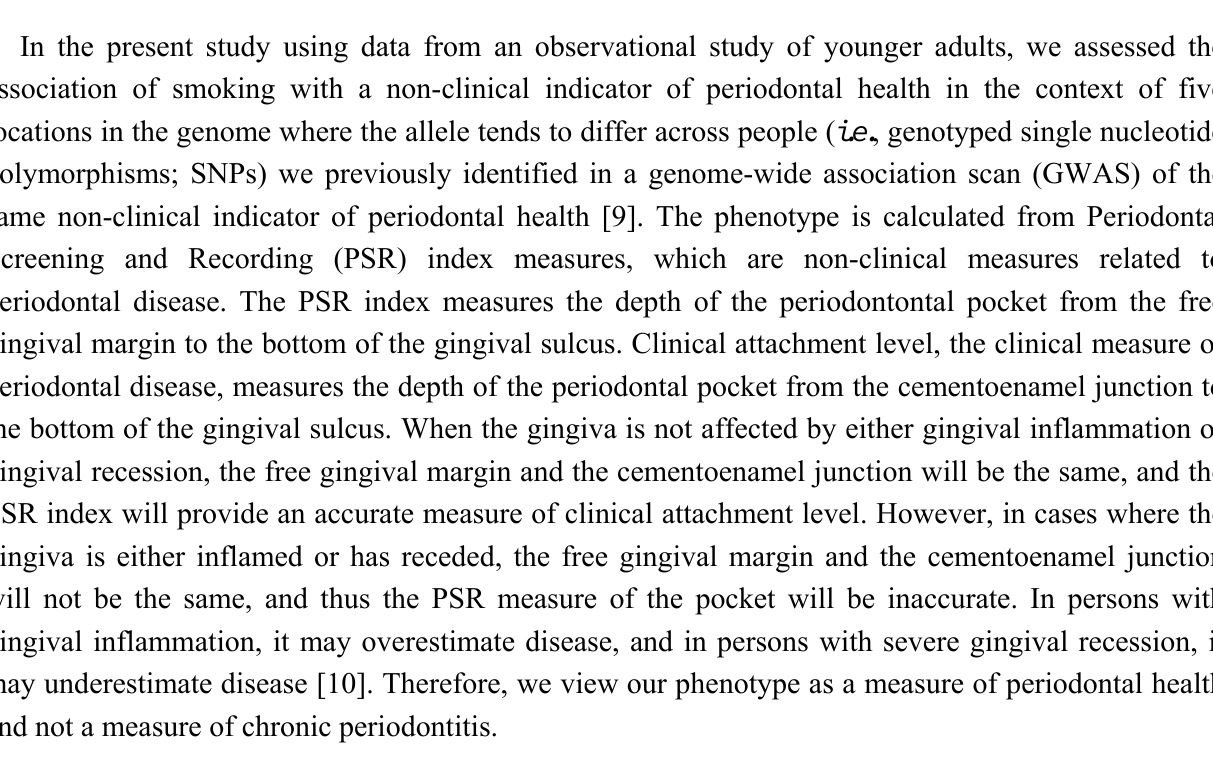
Table 1. Results of logistic regression analyses relating age and smoking to PSR1 and PSR2.